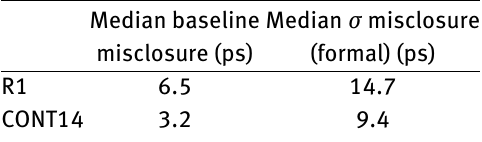
Table 1: Median baseline misclosure and corresponding formal errors for the triangle